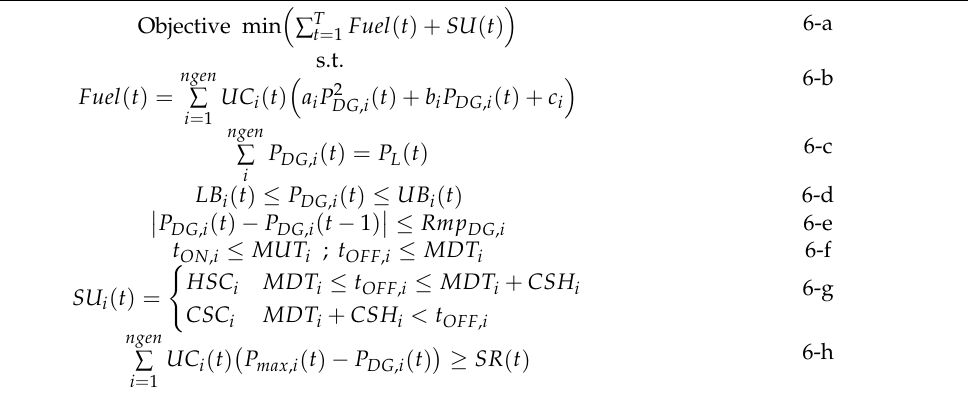
Table 6. Ten-unit unit commitment problem.